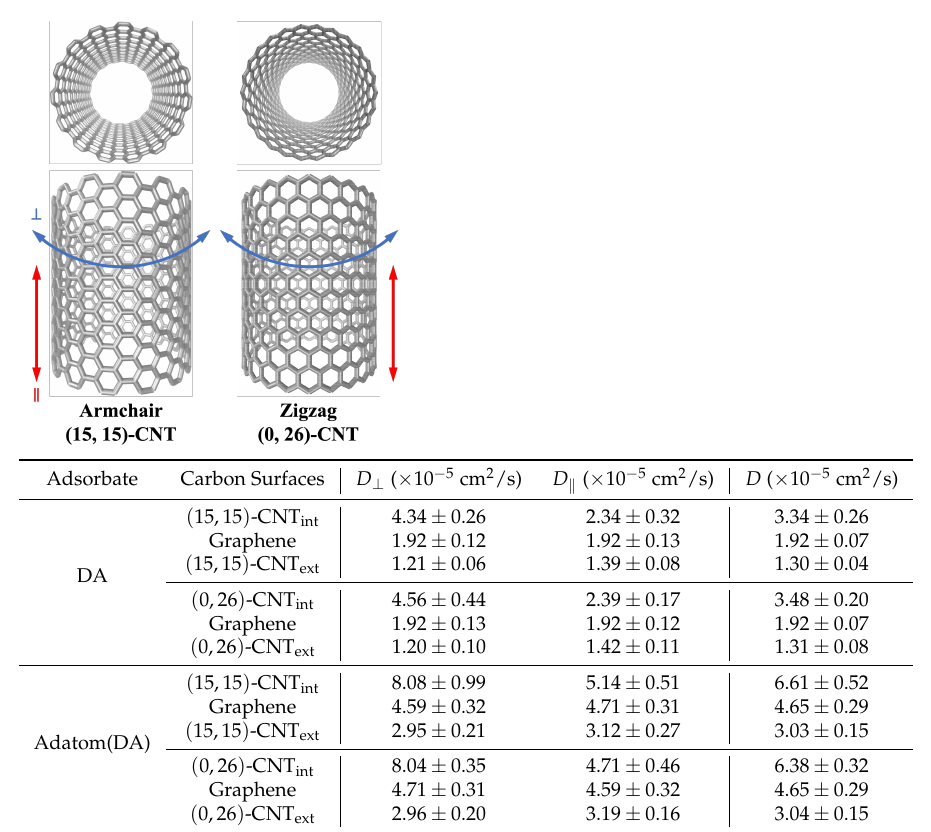
Figure 5. Diffusion coefficients of DA and adatom(DA) on armchair and zigzag CNTs. Armchair and zigzag CNTs are two conformations which describe the carbon atom arrangements along the perpendicular direction. The values of the diffusion constants D ⊥ , D (cid:107) and the overall 2D D were calculated from the MSDs of the adsorbates on the different surfaces. The 1D diffusion constants on the flat graphene surface along the direction with the same chirality as each CNT direction were chosen for the comparison. Finite system size results are shown here as calculated within the 100 Å long